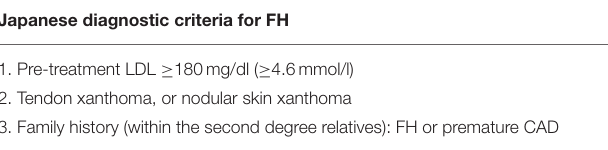
TABLE 4 | Dutch Lipid Network criteria for diagnosis of familial hypercholesterolemia. DUTCH LIPID NETWORK